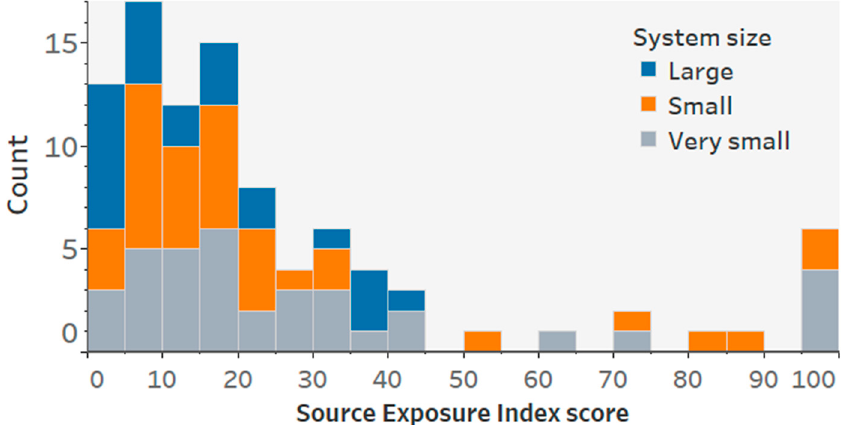
Figure 5. Distribution of Source Exposure Index scores for utilities serving variable number of consumers, with very small, small, and large systems serving less than 500, 500 to 5000, and more than 5000 people, respectively. Table 2. Correlation coefficients between input variables and the exposure index. Values relative to the total amount of downstream consumers (TC), a raster grid of population distribution, were added to the analysis.